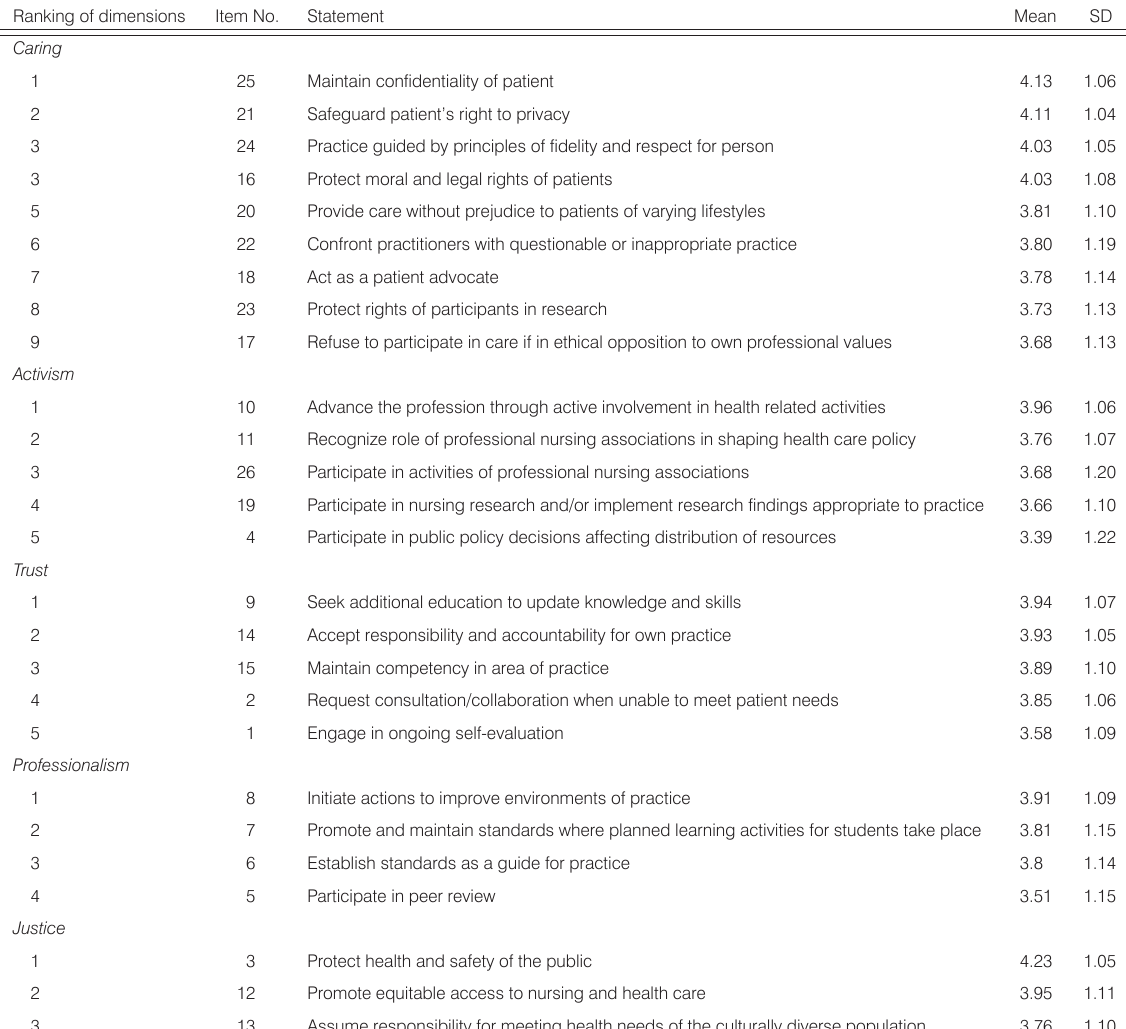
Ranking of dimensions